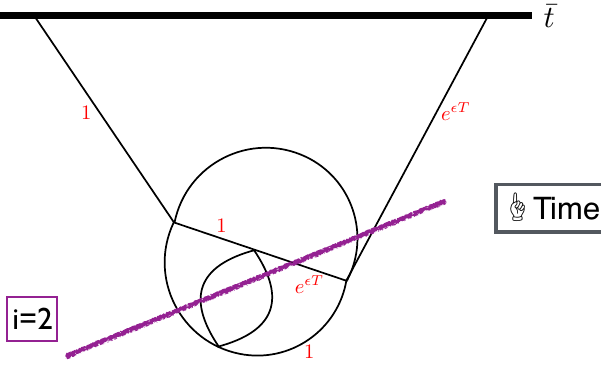
Figure 1 . An in-in diagram with all G ±± propagators where we demonstrate the structure of contributions to eq. (2.8). The coarse, purple line is a partition that divides vertices into those whose time argument evaluates to the final correlation time, ¯ t , from those set to the early-time cutoff, T . Since the original integral (eq. (2.7)) is time-ordered, this dividing line occurs between the i th and ( i + 1) th vertices. Here we show it in a four vertex graph for i = 2 . The red labels on some propagators show the (cid:15) dependence, 1 or e (cid:15)T , that results from deformation (cf. eq. (2.10)). We see that the factor is 1 if the propagator connects two vertices on the same side of the partition. If, however, a propagator straddles the partition, then there is a suppressing e (cid:15)T . Furthermore, because the propagators that connect to the external correlation point have one end evaluated at ¯ t even before integration, the external correlation points are always above the partition line; the only way to avoid suppression is if every vertex evaluates to ¯ t (corresponding to the partition drawn below the entire graph and cutting no propagators), which is precisely the surviving contribution in eq. (2.9). We note that this straddler argument fails for the case of a vacuum bubble, as all vertices can evaluate to T without any suppression, giving a finite